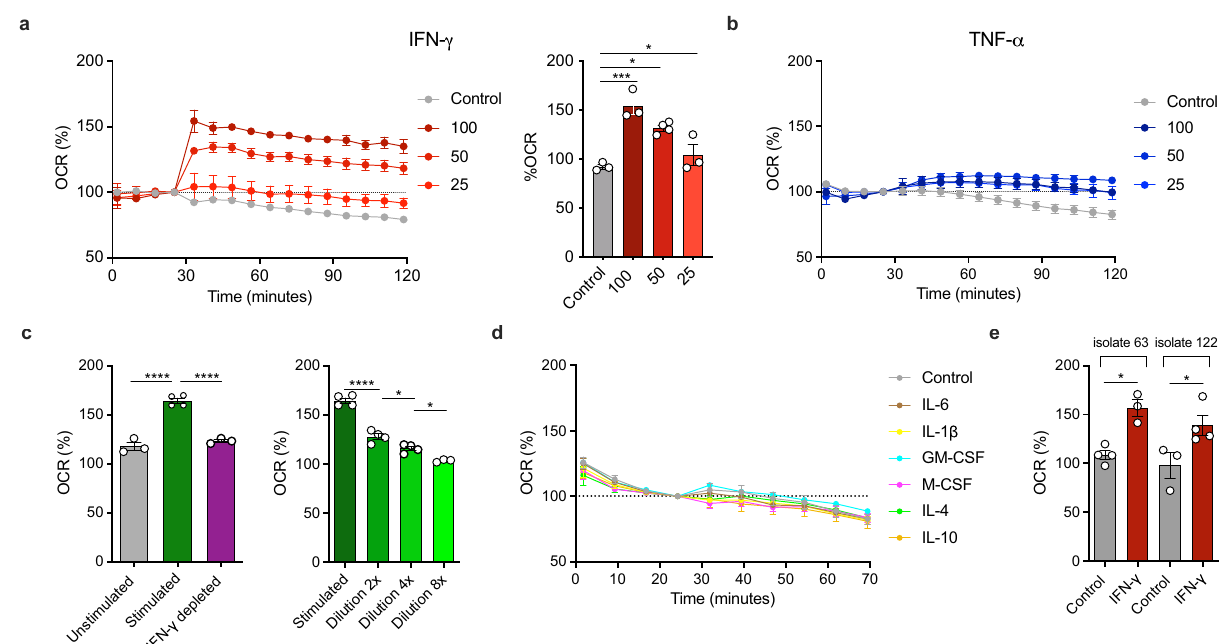
Fig. 1 IFN- γ stimulates respiration in Mtb . Addition of recombinant human IFN- γ to Mtb at indicated concentrations (ng/mL) induces dose-dependent increase in OCR ( a ) whilst no effect was observed with recombinant human TNF- α ( b ). Media derived from stimulated (anti-CD3/CD28 treated) PBMC media, likewise increased OCR, which was abrogated upon IFN- γ depletion ( c ). Dilutions of stimulated media led to a dose-response reduction of the effect. This effect appears to be speci fi c to IFN- γ as several cytokines failed to induce increased respiration ( d ). Clinical Mtb isolates also increased OCR in